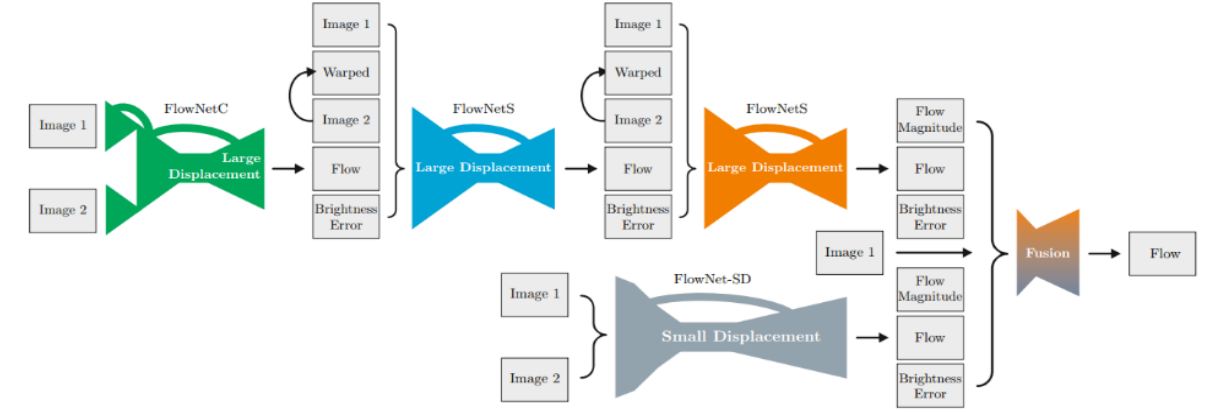
Figure 2. Schematic view of FlowNet 2.0 (Ilg et al.,